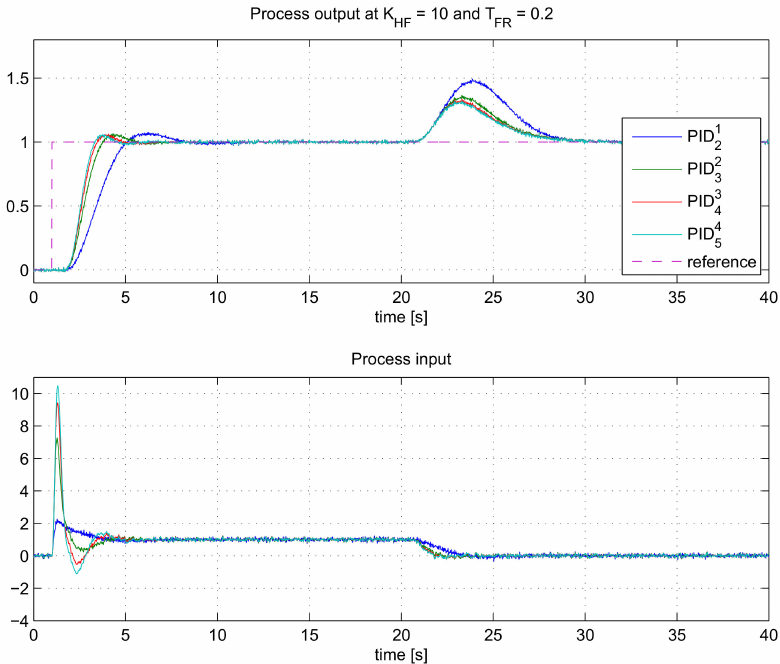
Figure 9. The closed-loop responses for the process G P 3 ( s ) when using controllers with different controller orders PID m n , at K HF = 10 and n = m +